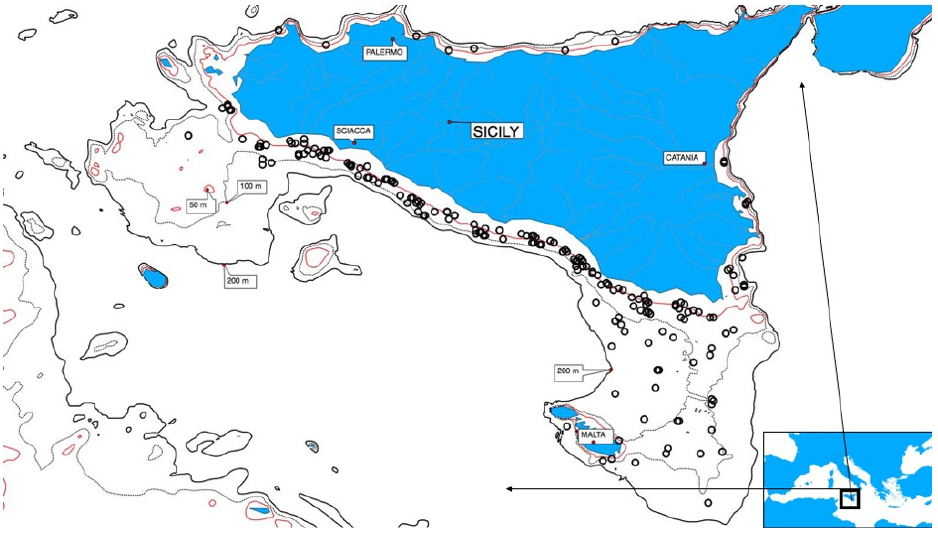
Figure 1. Locations of European anchovy sampling performed on the continental shelf in the Strait of Sicily.